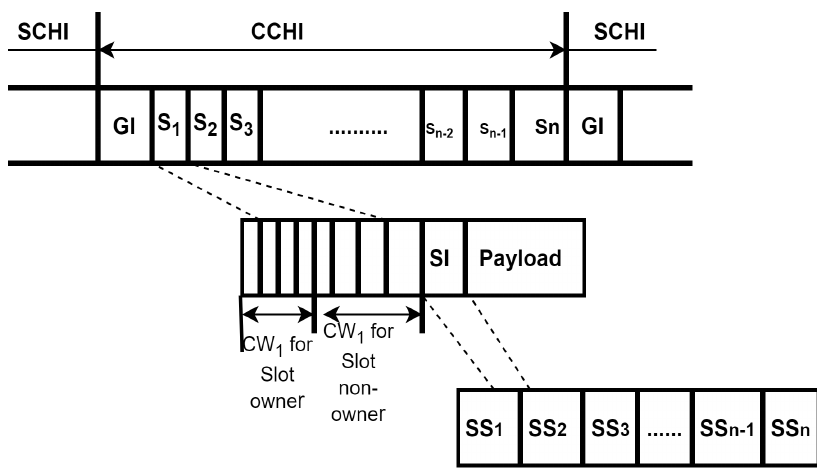
Figure 14. Overview of CT MAC